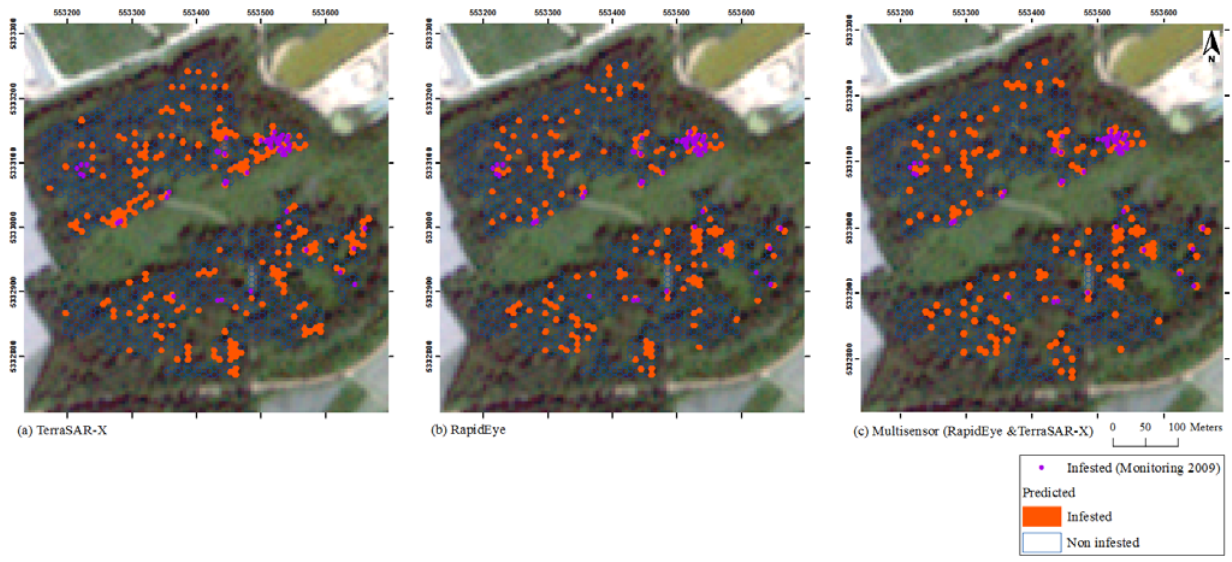
Figure A1. ME predication maps for bark beetle green attack (RapidEye image in